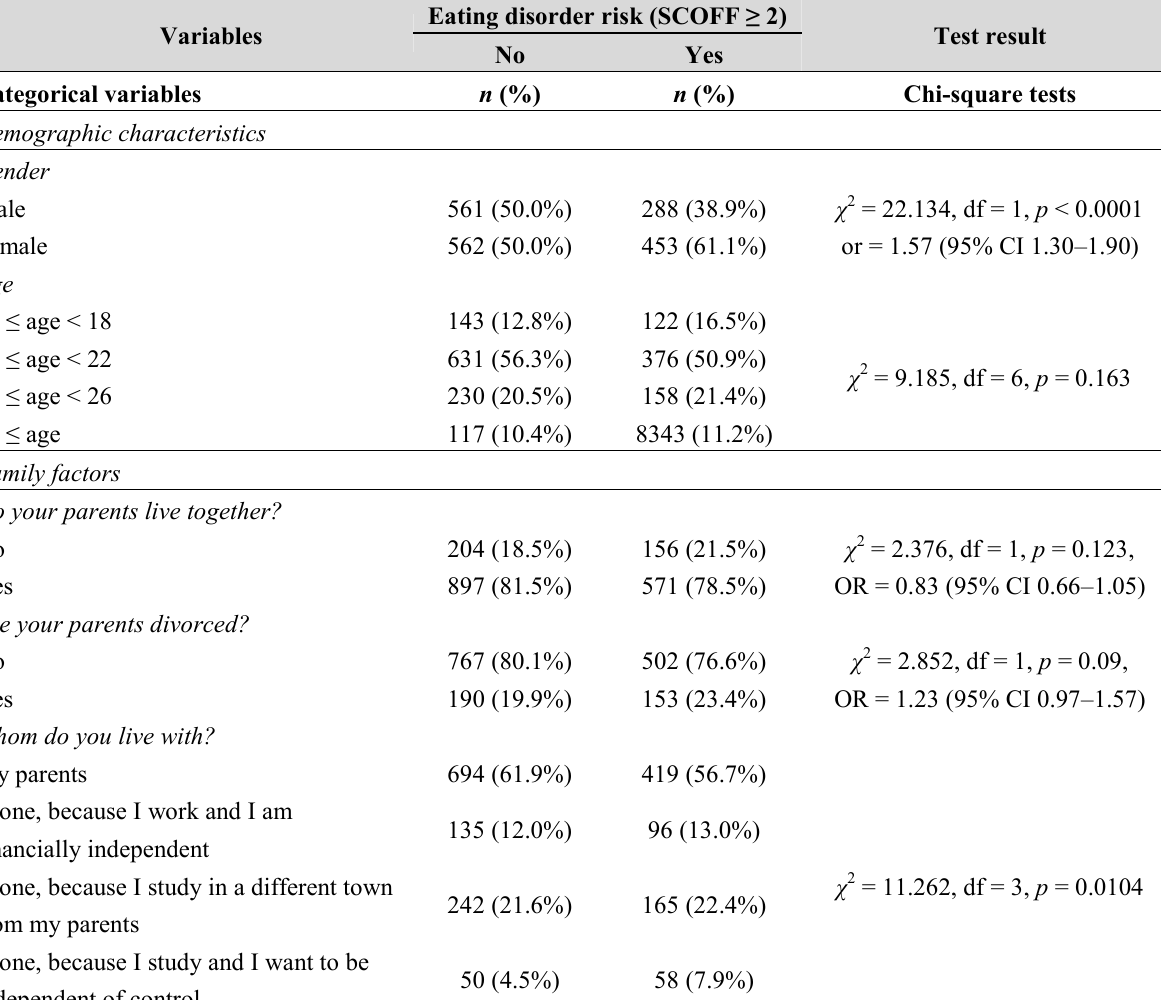
Table 2. Univariate analyses of eating disorder risk with other